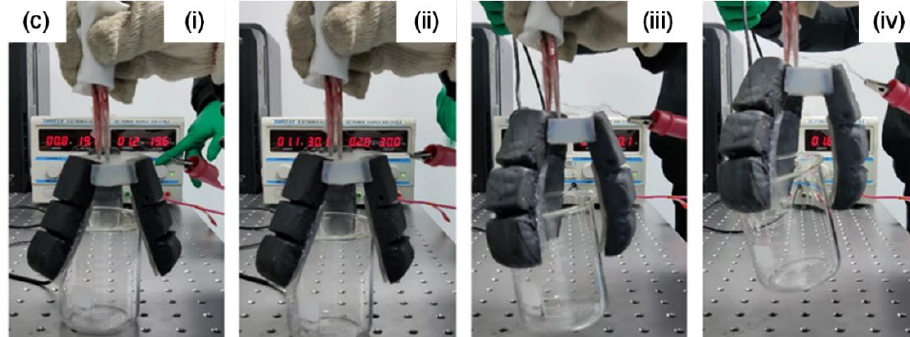
Figure 7. Demonstration of grasping objects ( a ) shuttlecock, ( b ) tennis ball and ( c ) glass beaker with the as-prepared soft gripper. ( i – iv ) indicate the initial state, bending starting and touching the objects, holding the objects and lifting the objects, respectively.